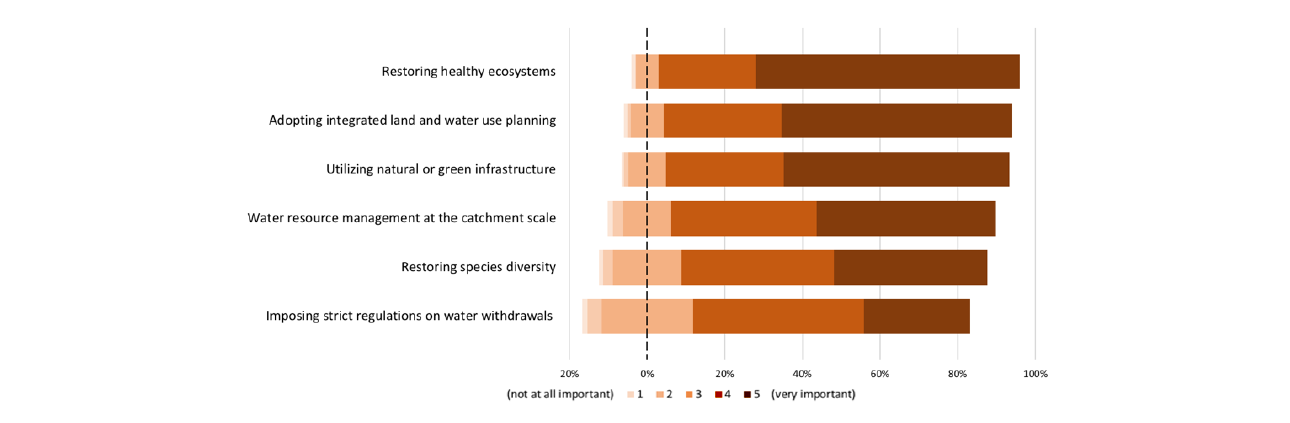
Fig. 5 . Strategies that build resilience in freshwater systems. Survey respondents were asked to rate, on a scale of 1 to 5, each of the strategies in terms of how important they are for achieving resilience in water resource management. While the strategies were randomly ordered on the survey, they are shown here from the highest rated at the top to the lowest rated at the bottom.